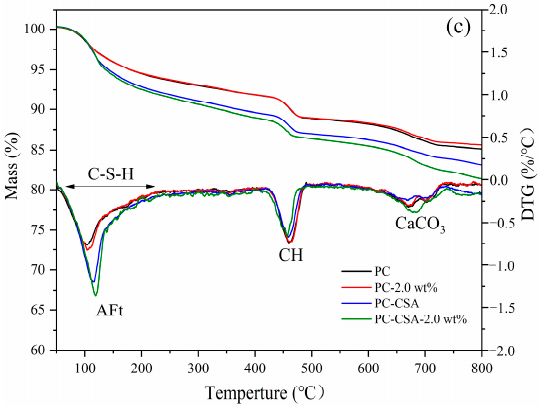
Figure 10. Thermogravimetric analysis of cement ( a ) 10 h; ( b ) 1 d; ( c ) 3 d. Table 7. The generation of BW and CH (g/100 g of the dry weight of cement pastes at 550 °C).